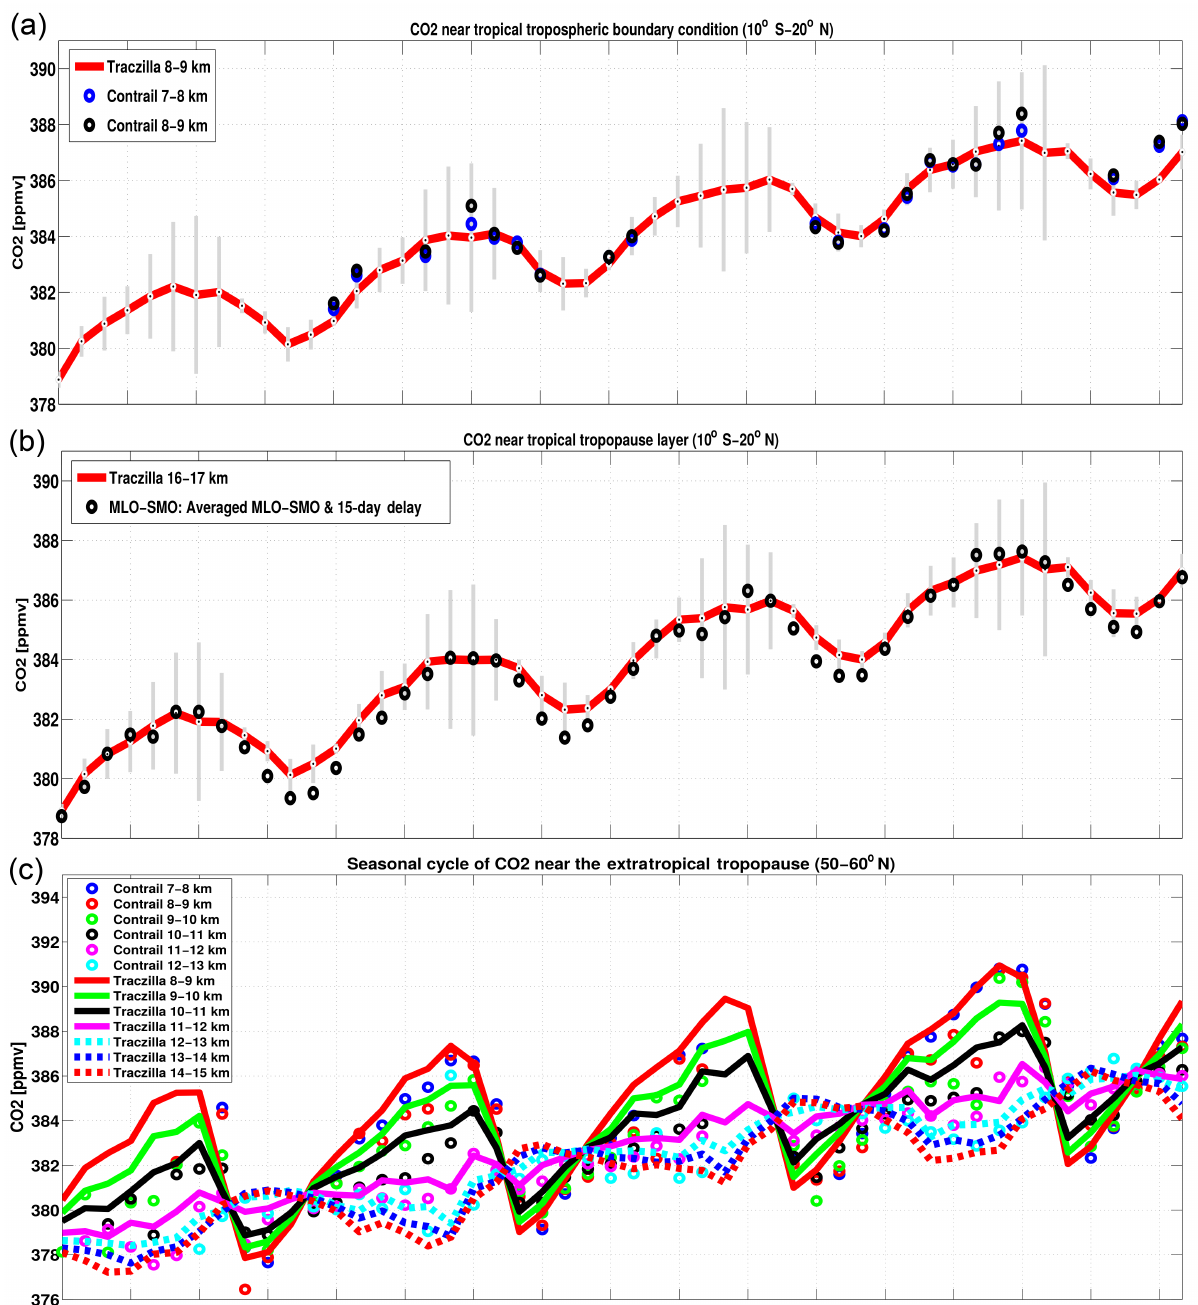
Figure 5. Temporal evolution of the monthly mean CO 2 seasonal cycle from TRACZILLA calculations (line) compared with CONTRAIL and ground measurements (circle). (a) Comparison model with CONTRAIL in the tropospheric region above the tropospheric boundary in the latitude range 10 ◦ S–20 ◦ N. (b) In the upper tropospheric region close to the tropical tropopause and the latitude range 10 ◦ S–20 ◦ N, comparison with the average of surface station data at Mauna Loa, Hawaii (19 ◦ N), and American Samoa (14 ◦ S) delayed by 15 days. (c) Comparison model with CONTRAIL in the upper troposphere near the extratropical tropopause at 50–60 ◦ N and at several heights from 7 to 15km. The error estimated from the reconstruction is indicated as vertical grey